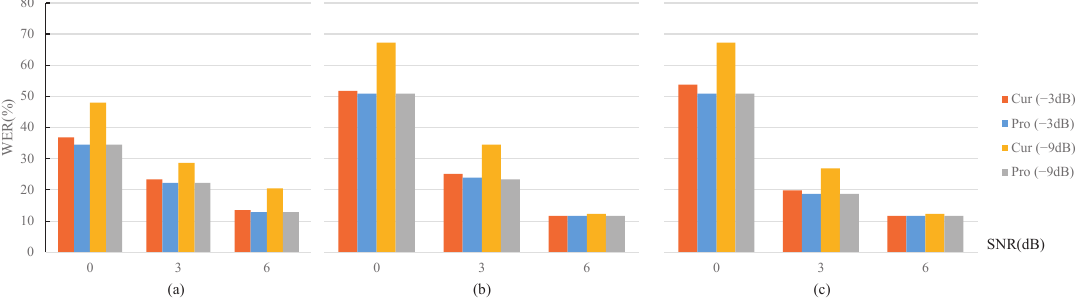
Figure 8. WER comparisons under different noise and SNR conditions. ( a ) White noise. ( b ) Babble noise. ( c ) Factory1